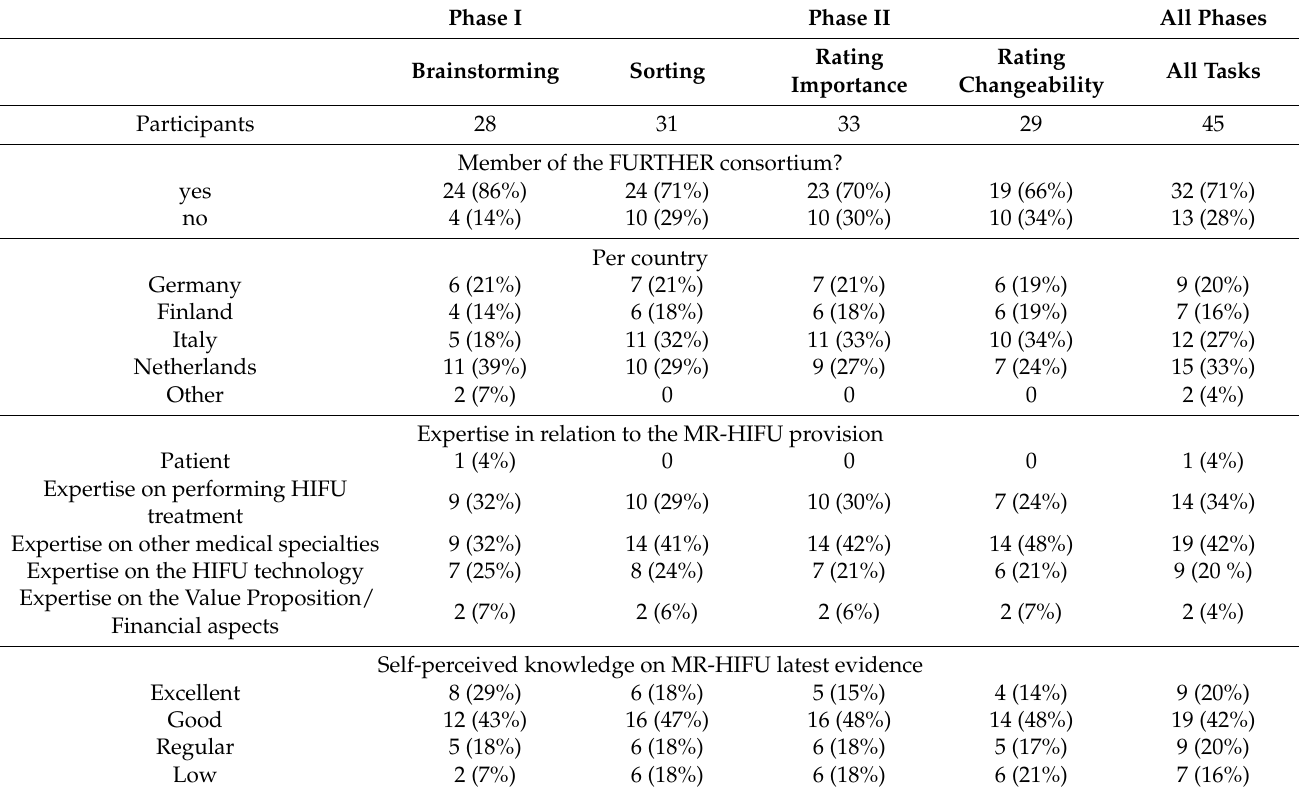
Table 1. Participants’